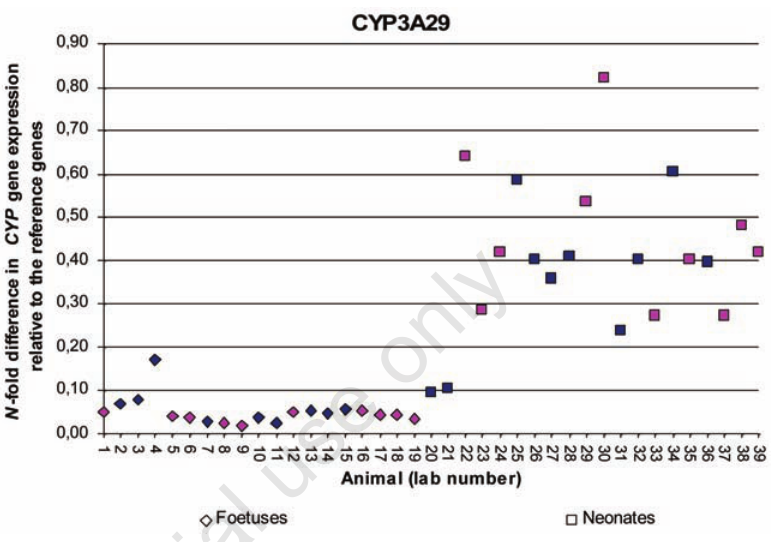
Figure 2. Box plot show- ing the difference in the relative expression of CYP3A29 depending on age (y-axis depicts the ∆Cp values).